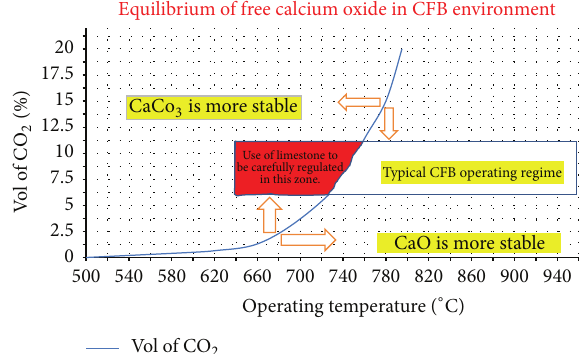
Figure 9: Recarbonation-prone regime for limestone addition.